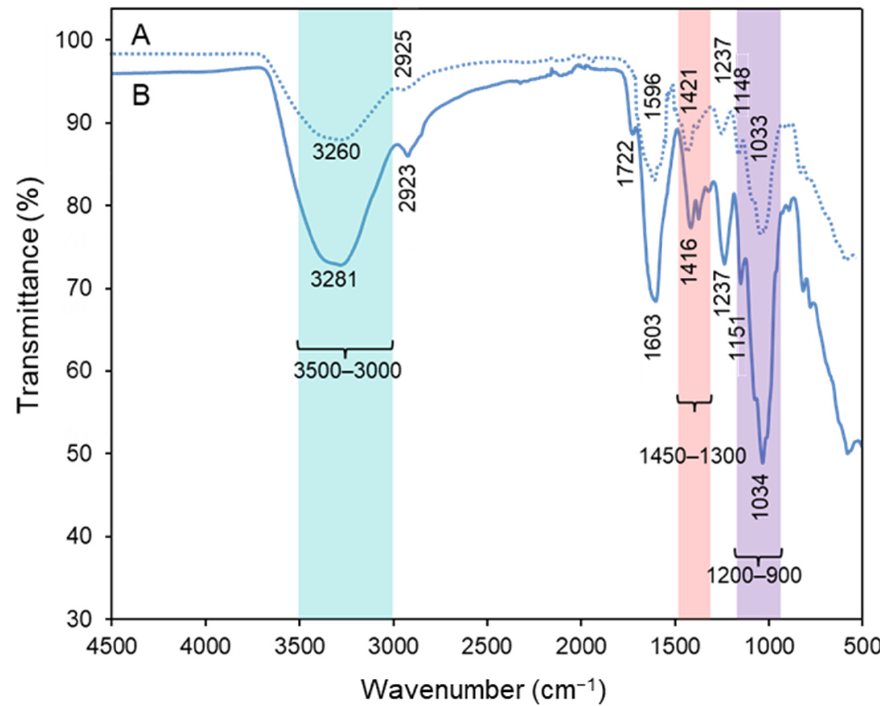
Figure 5. FTIR spectra of purified A. macleodii Mo169 EPS ( A ) and its SeNPs bio-nanocomposite ( B ).